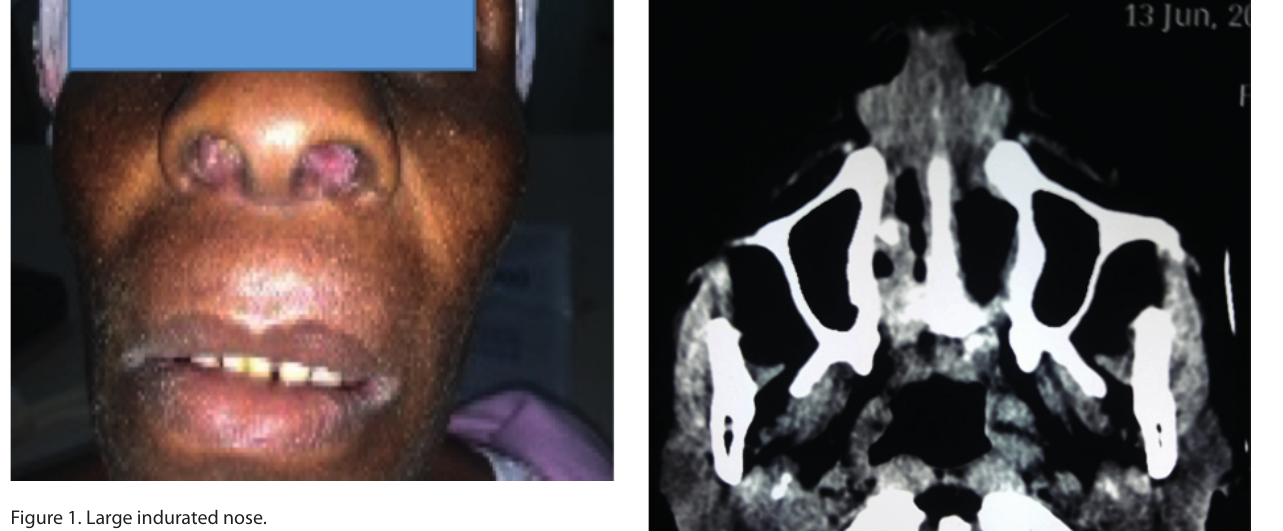
Figure 1. Large indurated nose.